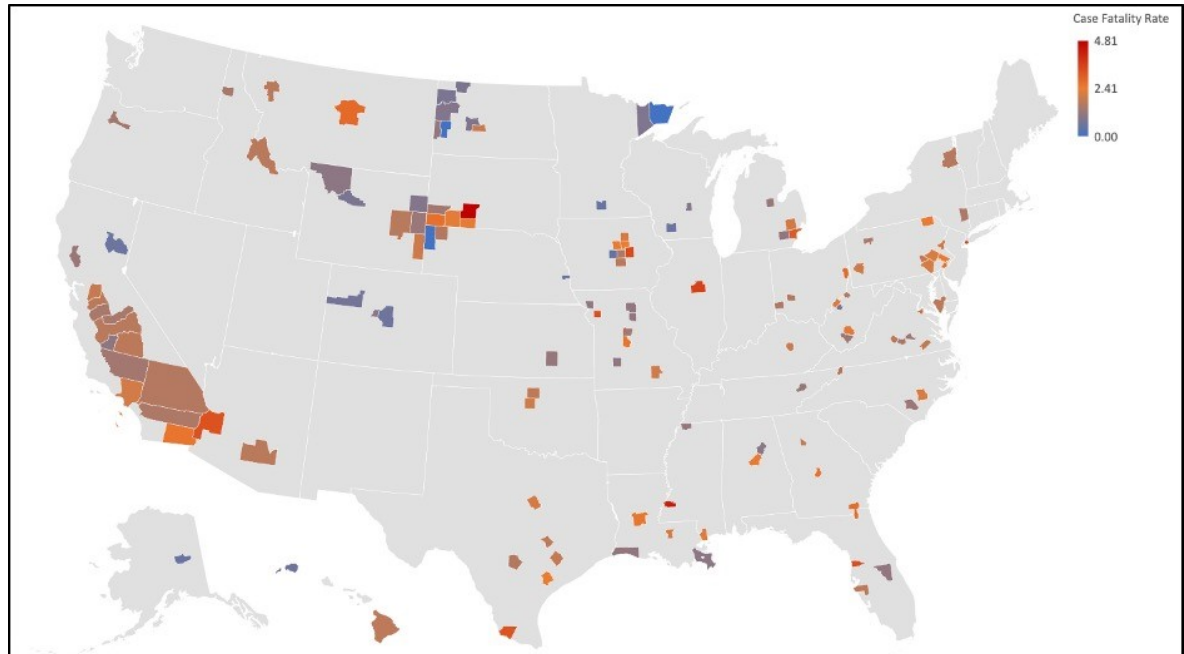
Figure 4. Substudy case fatality rate of U.S. counties map. Map of case fatality rates by county for the stratified substudy. High CFRs are observed in California’s Central Valley in addition to the Upper Midwest where low PM ₂ . ₅ concentrations were observed.